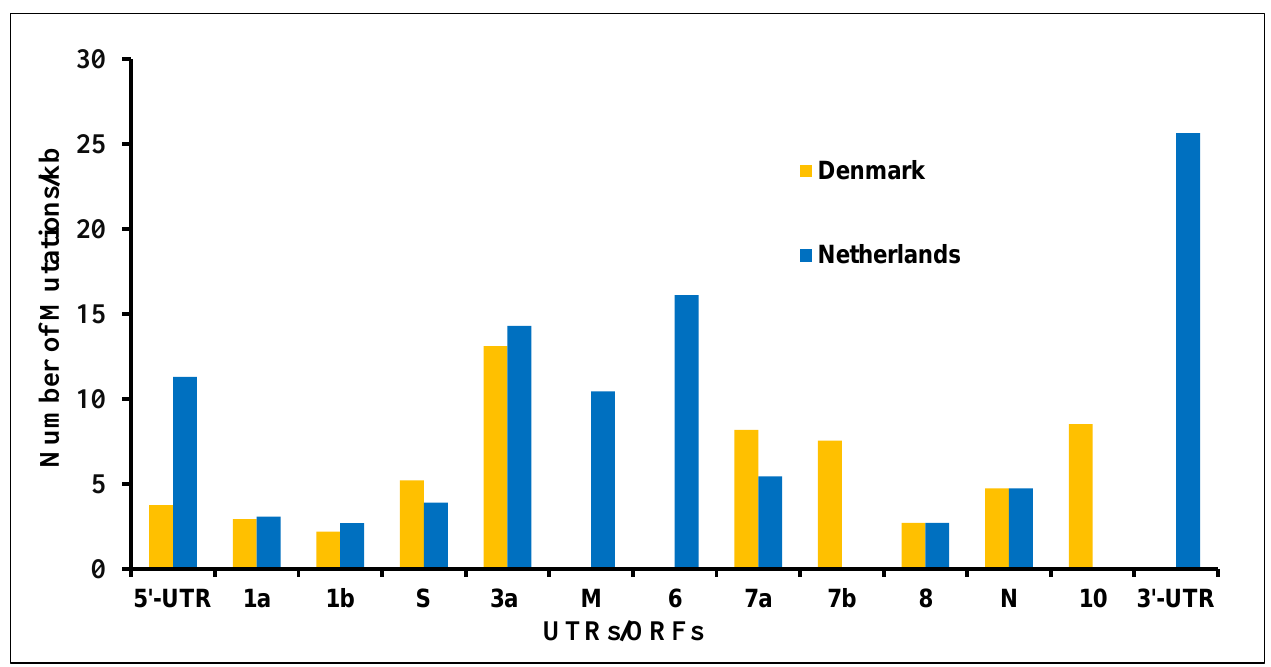
Figure 2. Mutations in various ORFs in the SARS-CoV-2 genome sequences derived from the Neth- erlands and Denmark.